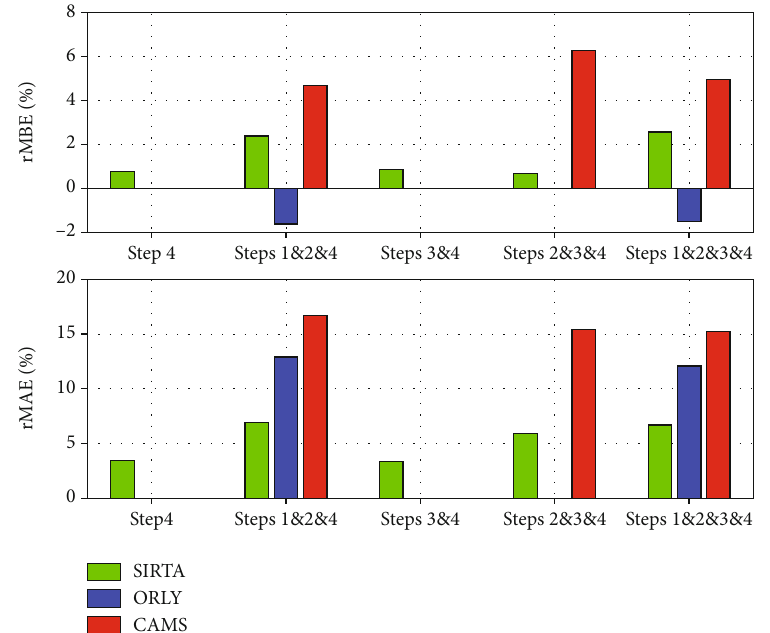
Figure 8: Modeling mean annual rMBE (top) and mean annual rMAE (bottom) of the whole simulation process as a function of the accessibility of the data sources (SIRTA, ORLY, and CAMS). The models are Helbig (step 1), Klucher (step 2), Adv. NOCT (step 3), and Evans (step